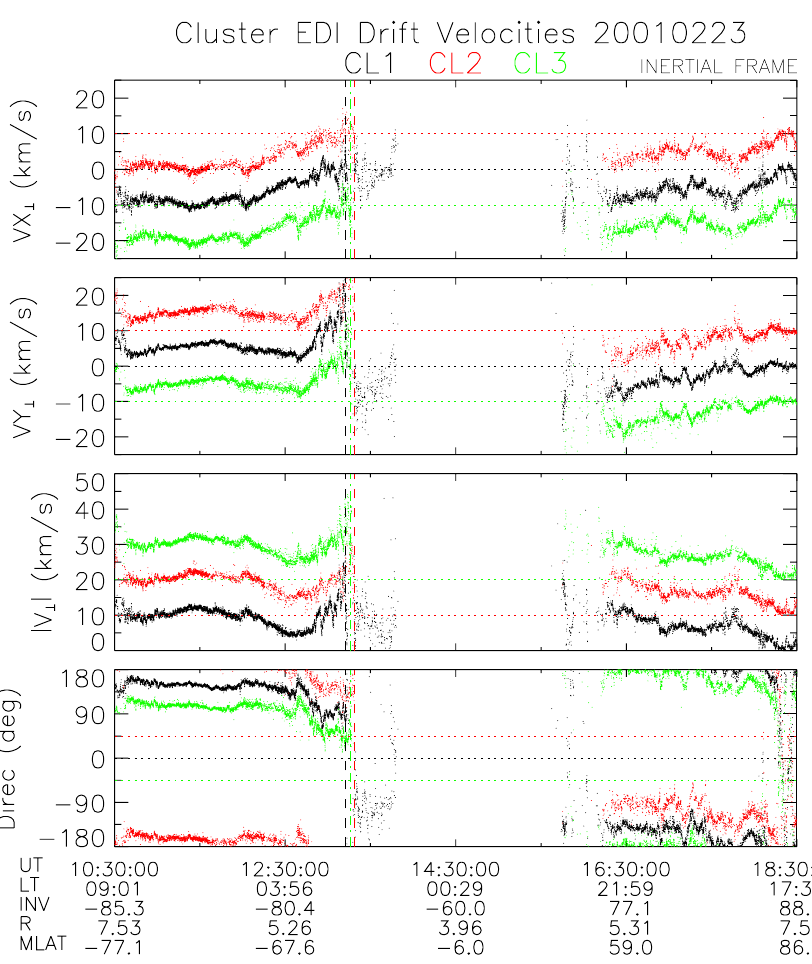
Fig. 4. EDI drift velocities for 23 February 2001, for spacecraft 1, 2, and 3, using the standard Cluster color assignments (1 = black; 2 = red; and 3 = green). V X ⊥ and V Y ⊥ are velocity components in the plane perpendicular to B with X ⊥ closest to X GSE and Y ⊥ closest to Y GSE . Dashed vertical lines mark the satellite encounters with the 1keV electron boundary (see Fig.